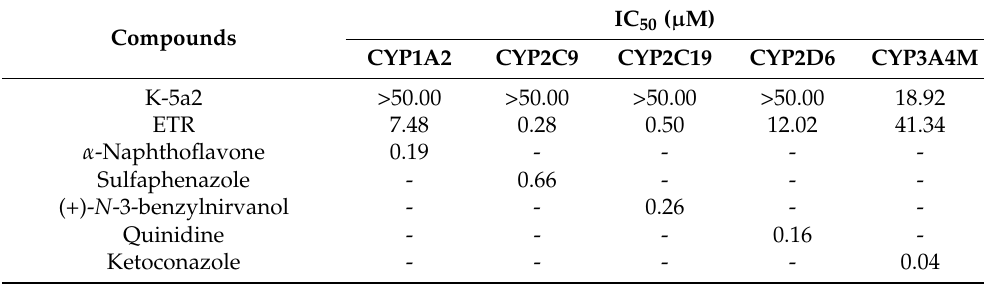
Table 4. CYP inhibitory activity of K-5a2.